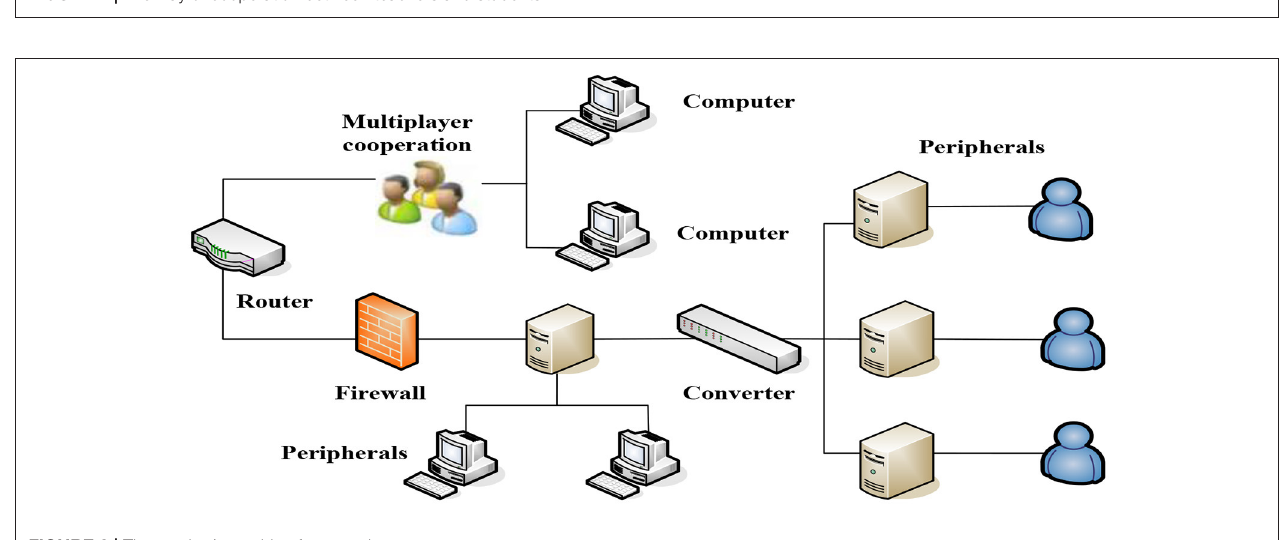
FIGURE 2 | The teacher’s teaching